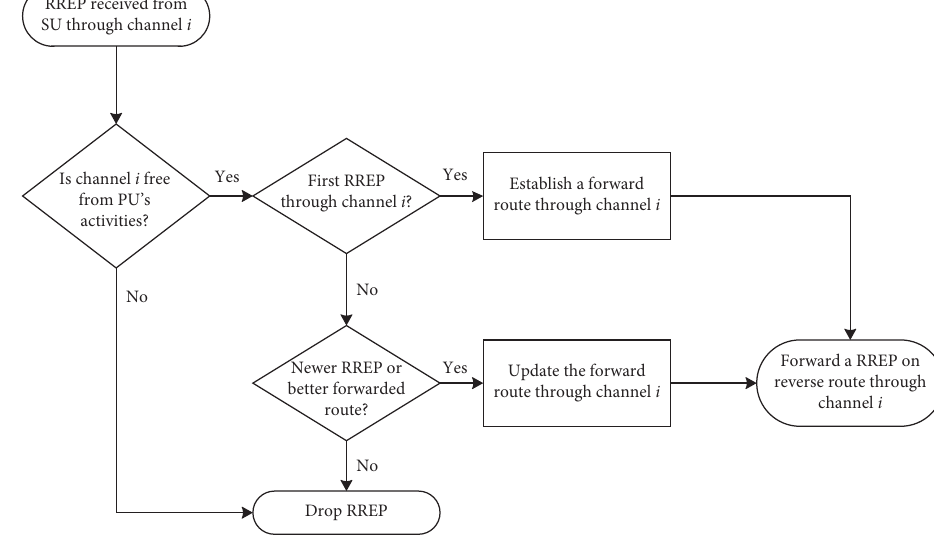
Figure 6: RREP mechanism in proposed MCSUI protocol.